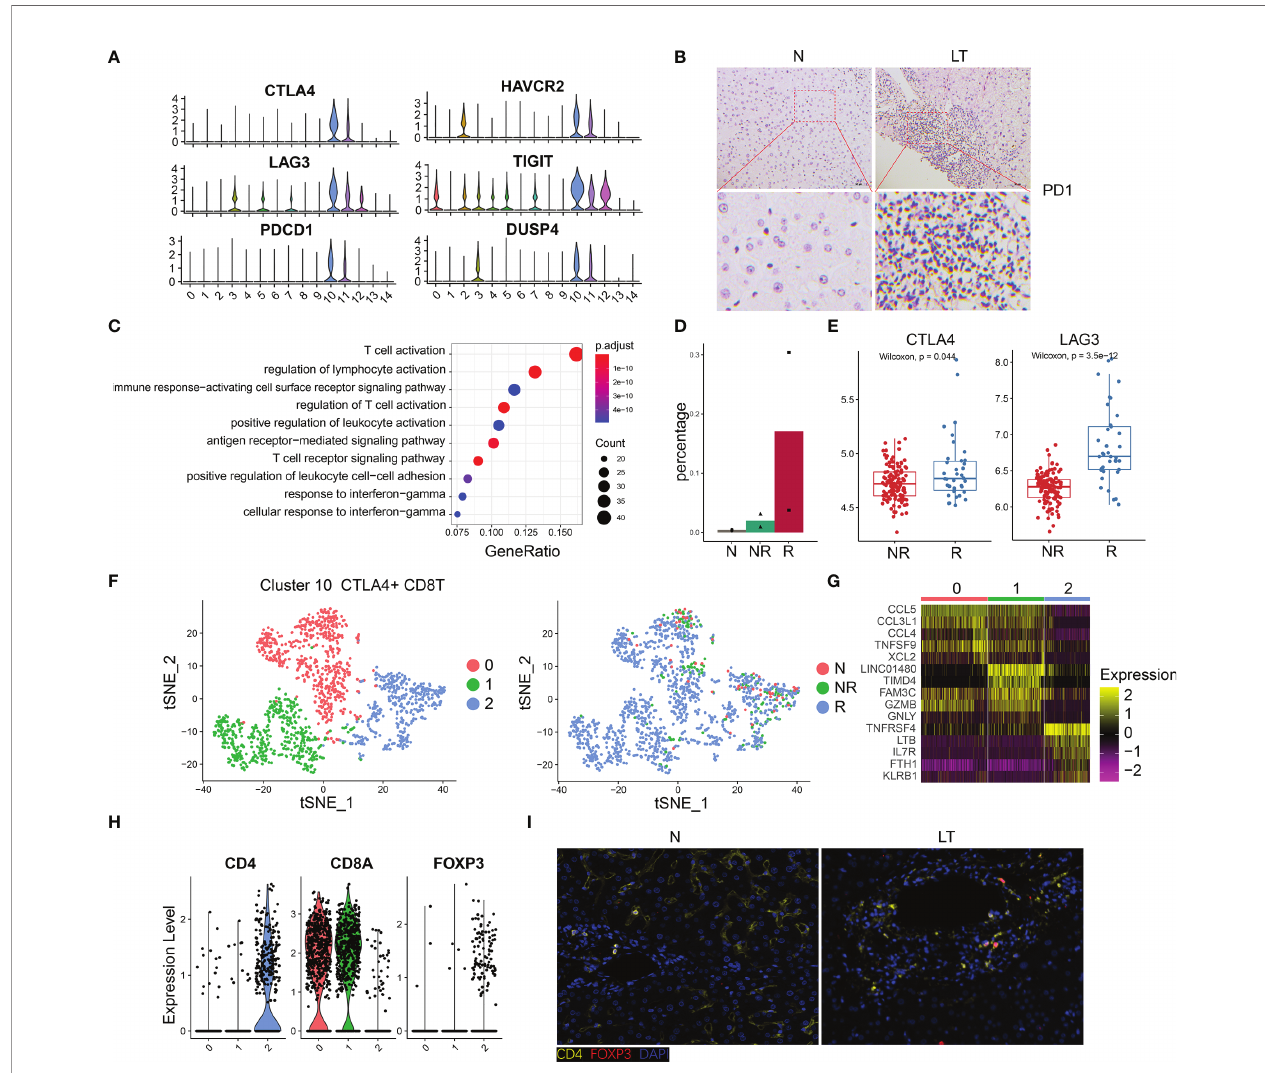
FIGURE 4 | The speci fi c phenotypes of exhausted CD8 T cells. (A) Expression of differentially expressed genes in exhausted CD8 T cells. (B) Immunohistology of PD1 in normal and liver transplantation tissue. (C) Enrichment analysis of Gene Ontology terms for differentially expressed genes in exhausted CD8 T cells. (D) Fractions of exhausted CD8 T cells in normal (n=3), stable (n=2), and rejection samples (n=2) after liver transplantation. (E) Bulk RNA-seq expression of CTLA4 and LAG3 in stable (N, n=129) and rejection samples (R, n=37) after liver transplantation. (F) tSNE plots showing re-clustering of exhausted CD8 T cells. (G) Heatmap of each cluster ’ s top 5 marker genes. (H) Expression of CD4, CD8A and FOXP3 among clusters. (I) Immuno fl uorescence including CD4 and FOXP3 in normal and liver